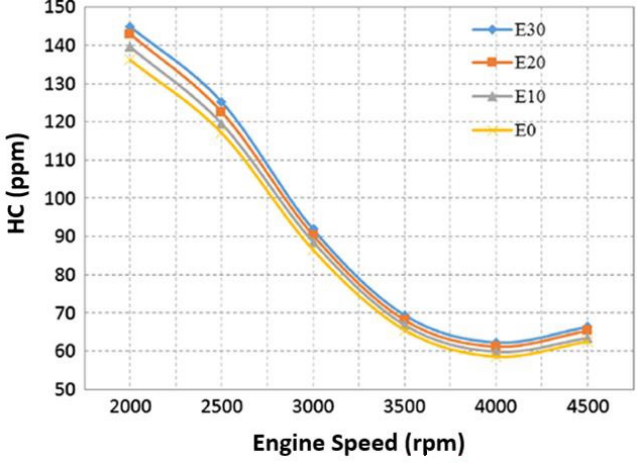
Figure 4. Variation in HC emissions with different engine speed and ethanol content in the blends: comparison between gasoline (E0), 10% ethanol v/v (E10), 20% ethanol v/v (E20) and 30% ethanol v/v (E30) [92]. Reproduced with permission from Applied Thermal Engineering; published by Elsevier, 2017. License Number: 5094070701800.